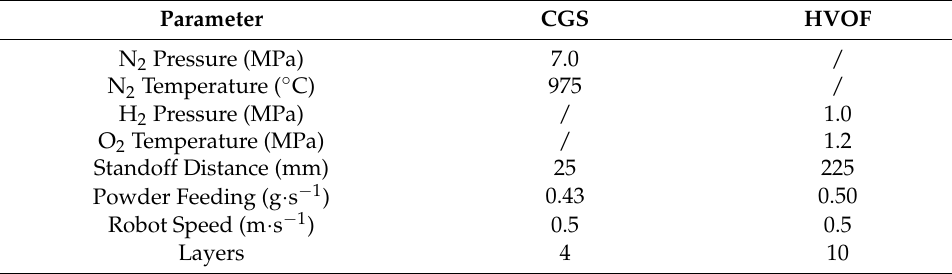
Table 1. Spraying parameters. CGS: cold gas spray. HVOF: high-velocity